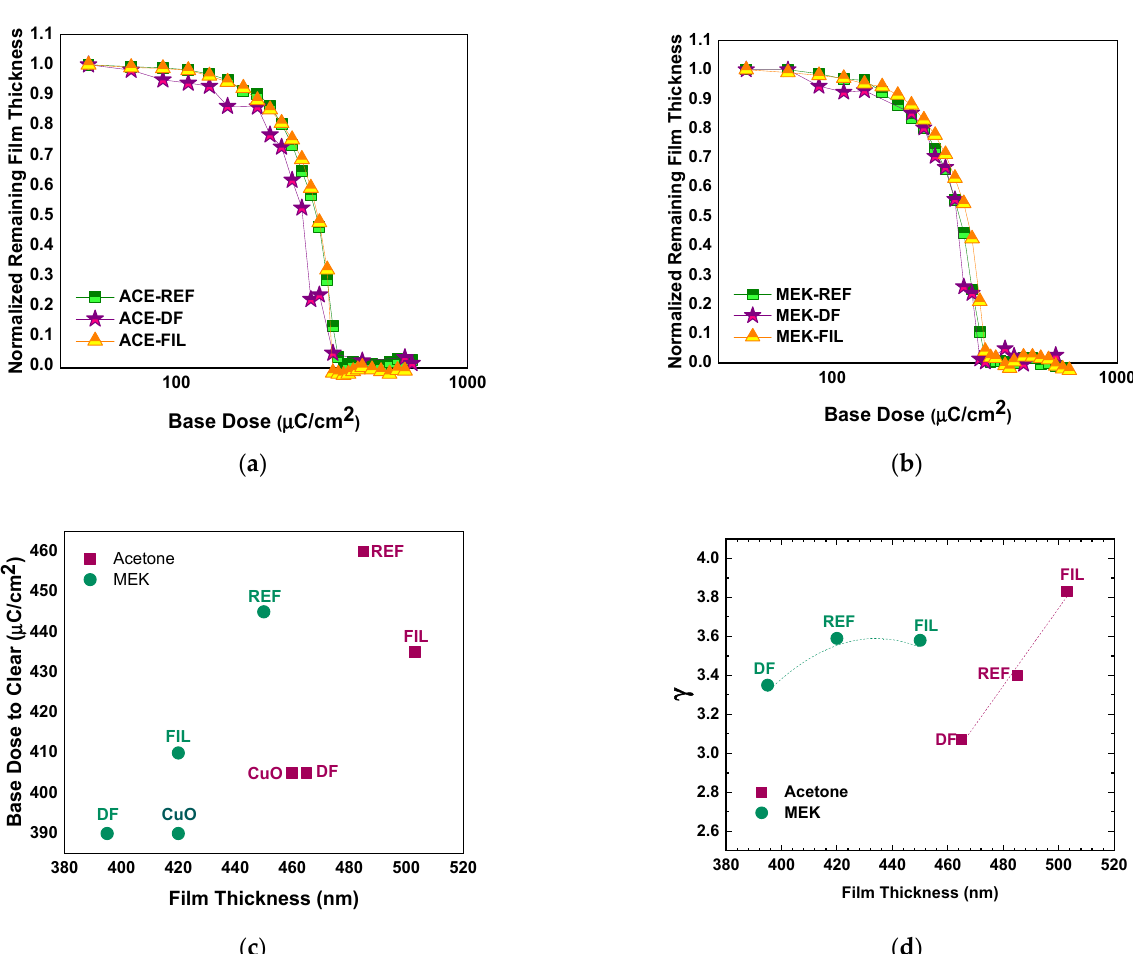
Figure 9. ( a , b ) Contrast curves (Normalized Remaining Thickness as a function of the base dose) for the acetone-based and MEK-based nanocomposite films, respectively. ( c ) Sensitivity expressed as minimum base dose-to-clear versus film thickness and ( d ) contrast γ versus film thickness for all nanocomposite films of Phase 2. Lines serve only as a guide to the eye.